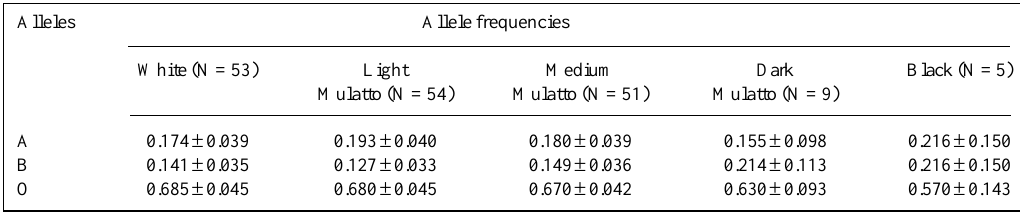
Table III - Distribution of glutathione S-transferase M1 allele frequencies in racial sub-groups of the Brasília sample. Alleles Allele frequencies White (N = 53)